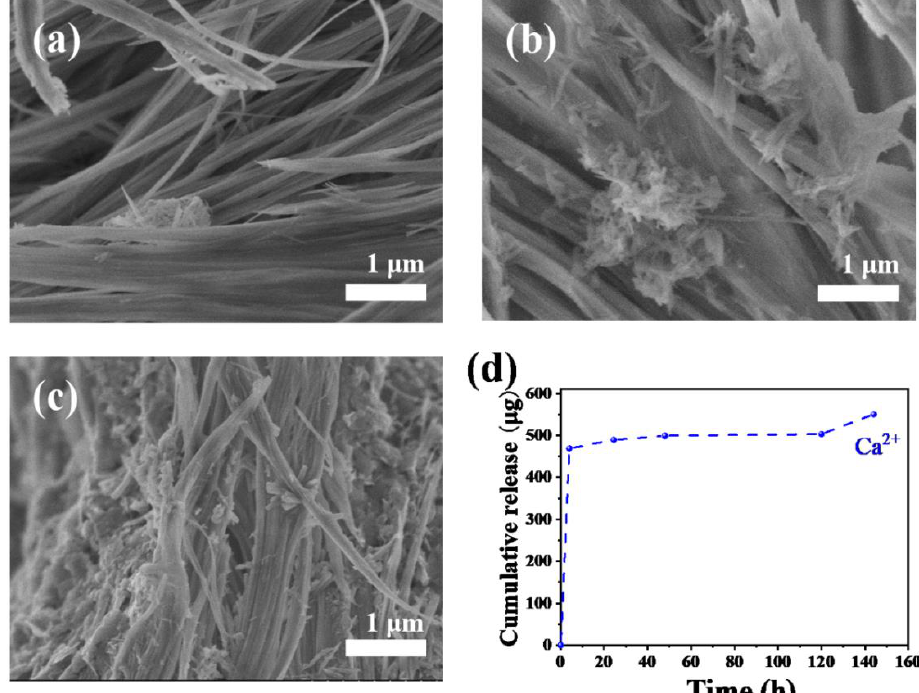
Figure 11. ( a – c ) SEM micrographs of the HAP nanowire/CS scaffolds after soaking in 1.5 × SBF for different times: ( a ) one day; ( b ) three days; ( c ) seven days. ( d ) In vitro Ca 2+ ion release curve of the ultralong HAP nanowire scaffold in normal saline at 37 °C for different times.